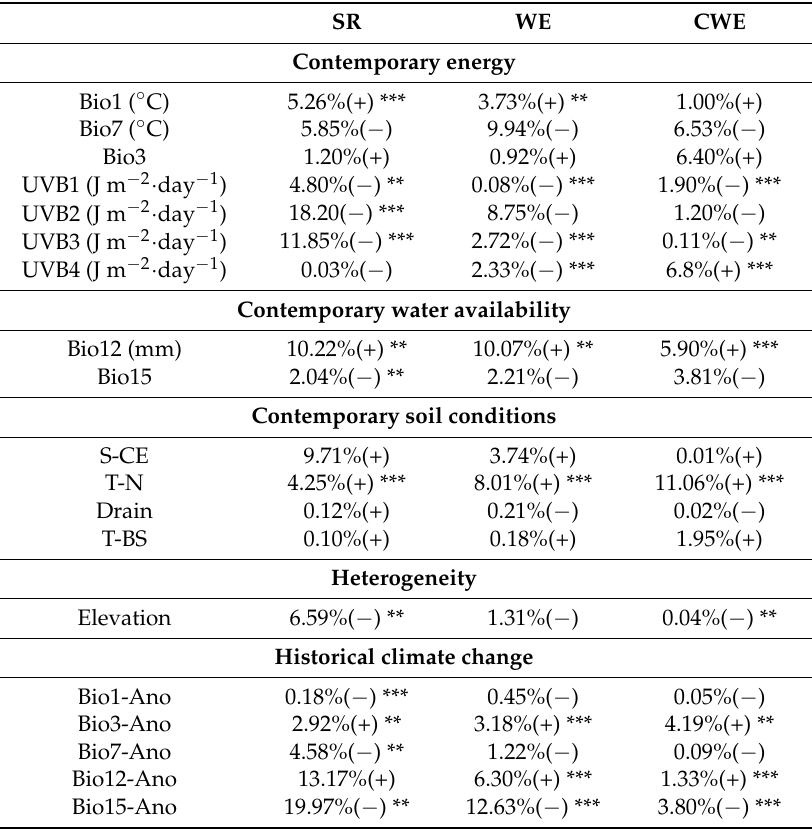
Table 3. Explanatory power (R 2 ) of the environmental variables for Salicaceae species diversity patterns evaluated by the generalized linear models (GLMs). Modified t-tests were used to examine the